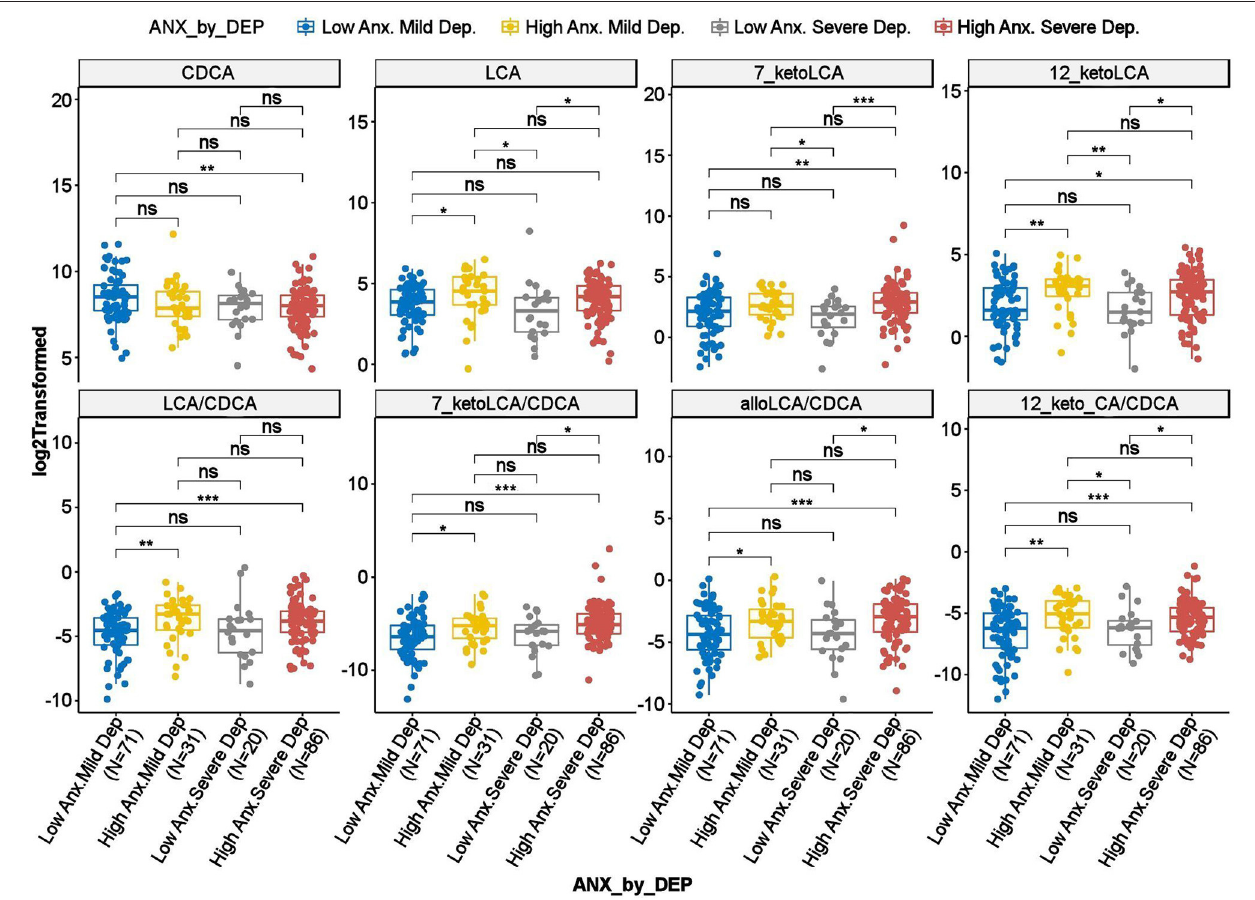
FIGURE 3 | Scatter plots of HRSD 17 scores by HRSA-total interaction for selected bile acids and ratios. Anx, Anxiety; CA, Cholic Acid; CDCA, Chenodeoxycholic Acid; Dep, Depression; HRSA-Total, 14-item Hamilton Anxiety Rating Scale; HRSD 17 , 17-item Hamilton Depression Rating Scale; LCA, Lithocholic Acid. *uncorrected p -value < 0.05. **uncorrected p -value < 0.01. ***uncorrected p -value < 0.001; ns, not significant.